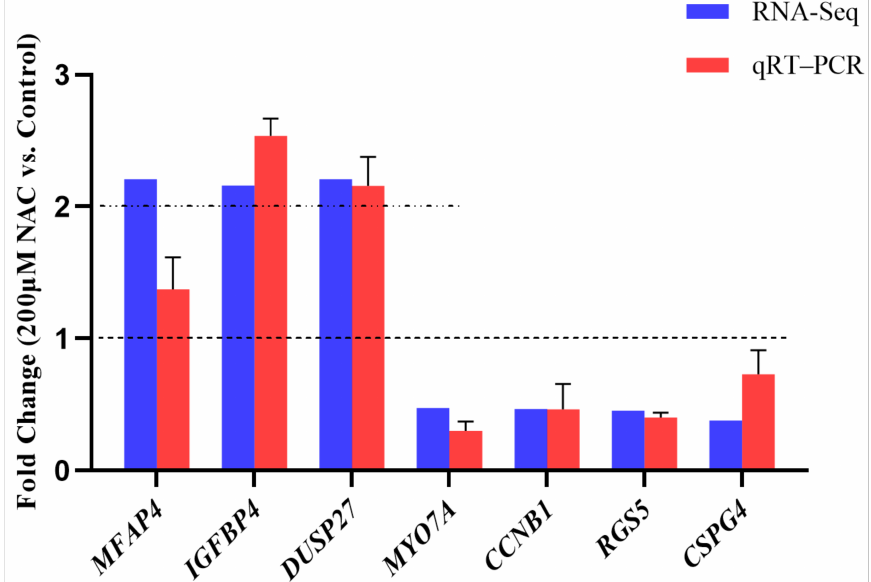
Figure 5. Relative abundance of 7 DEGs. RNA-Seq: Gene expression abundance obtained from transcriptome sequencing data, expressed as fold change. When the value corresponding to a gene is greater than 2, the gene is significantly expressed in the 200 µ M NAC group. If it is greater than 0 but less than 1, it is expressed significantly in the control group. qRT-PCR: Gene expression abundance by qRT-PCR. 2 − ∆∆ Ct was taken as the fold change. When the value corresponding to a gene is greater than 1, the gene is significantly expressed in the 200 µ M NAC group. N =